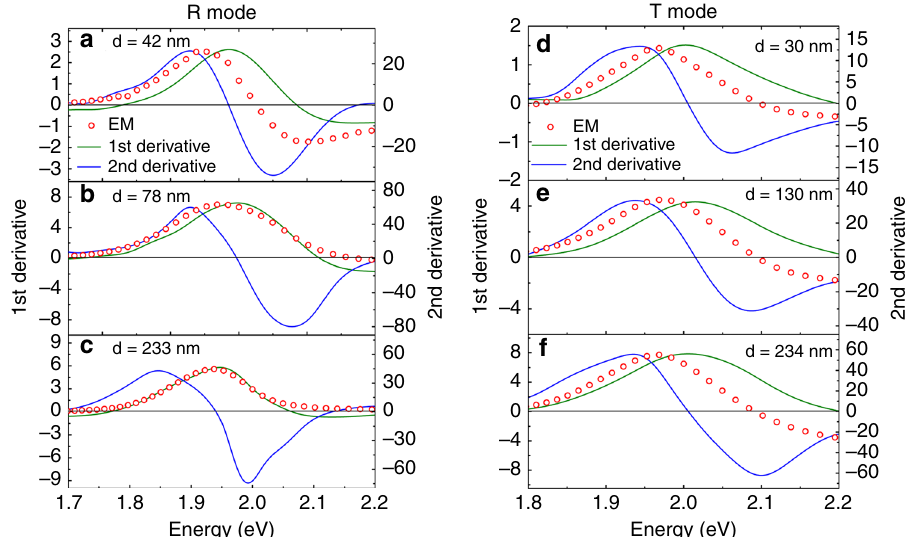
Fig. 5 Comparison of spectral position. Red circled dots refer to the measured electromodulation signal and solid lines refer to the calculated derivatives by device absorbance. a – c Re fl ection mode. d – f Transmission mode. The thickness here refers to thickness of active layer measured by pro fi